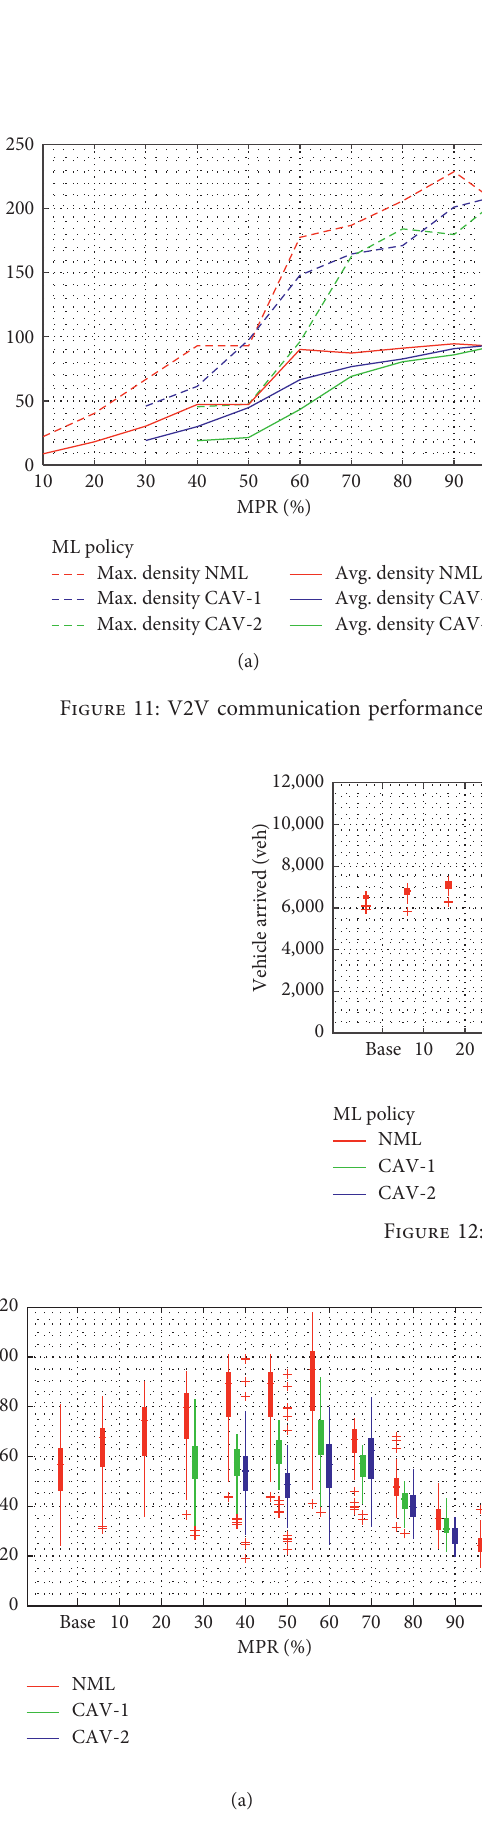
Figure 13: Average speed and delay. (a) Average delay. (b) Average